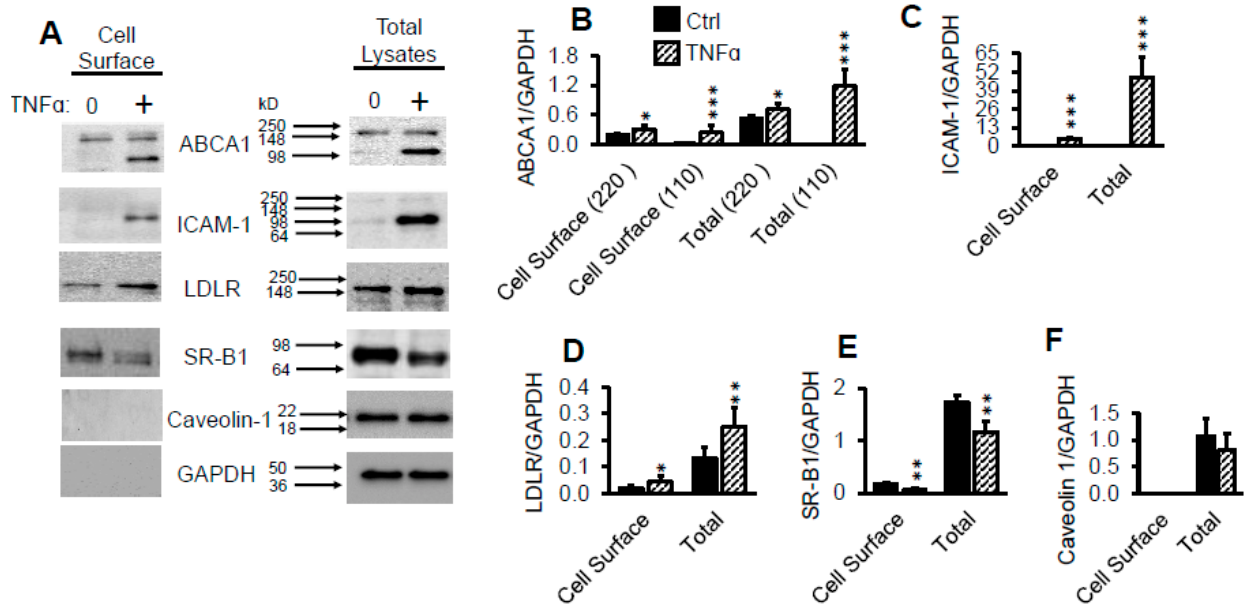
Figure 8. TNF α upregulates cell surface LDLR protein. ( A – F ), Confluent pHAECs in serum medium were pre-treated with 0 or 100 ng/mL TNF α (+) for 24 h in serum medium. The cells were then treated and lysed for total (Total Lysates) and biotinylated cell surface (Cell Surface) proteins, as explained under Materials and Methods, Section 4.14. ABCA1 bands ( A , B ) at ~220 and 110 kD are indicated. n = 3. *, **, ***, p < 0.05, 0.01, 0.001, vs. corresponding Ctrl.